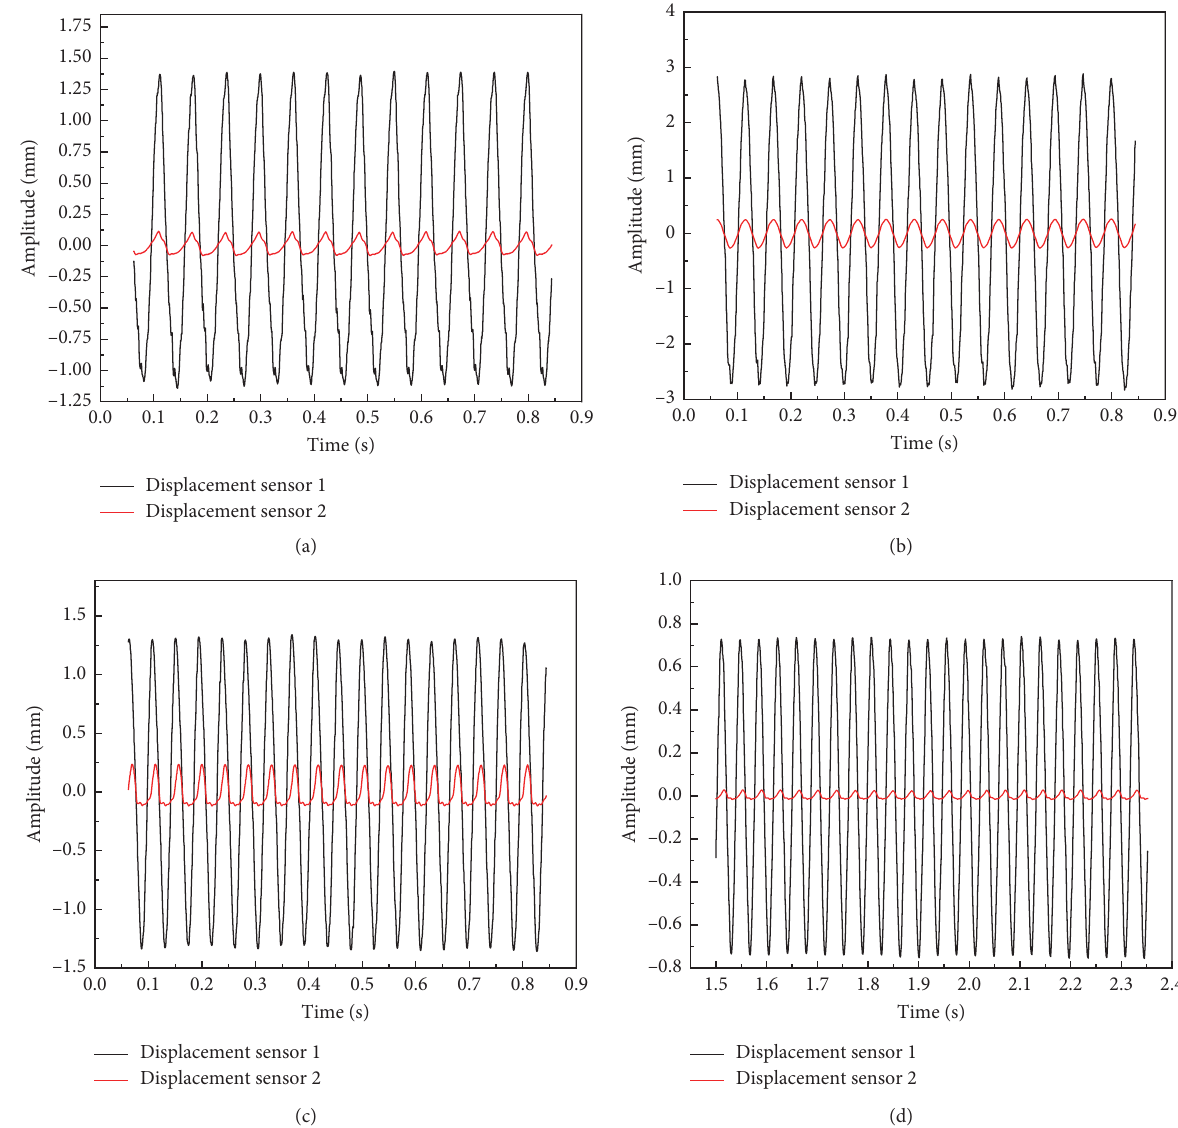
Figure 8: Experiment of amplitudes of experiment under four different rotational speeds: (a) 840r/min, (b) 1020r/min, (c) 1260r/min, and (d)